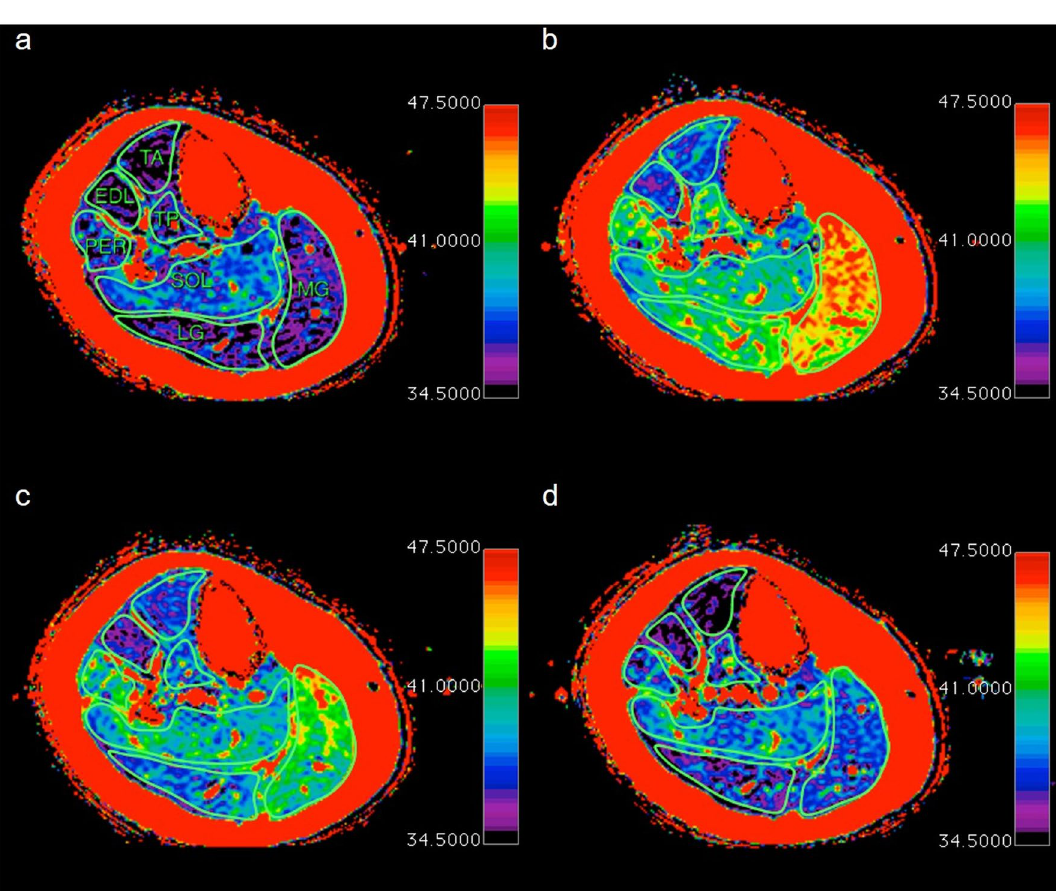
Figure 4. Time course for the relaxation times with the initial increase between baseline ( a ) and 2.5 min ( b ) with the following plateau tille 15 min ( c ) and the later decrease at 75 min ( d